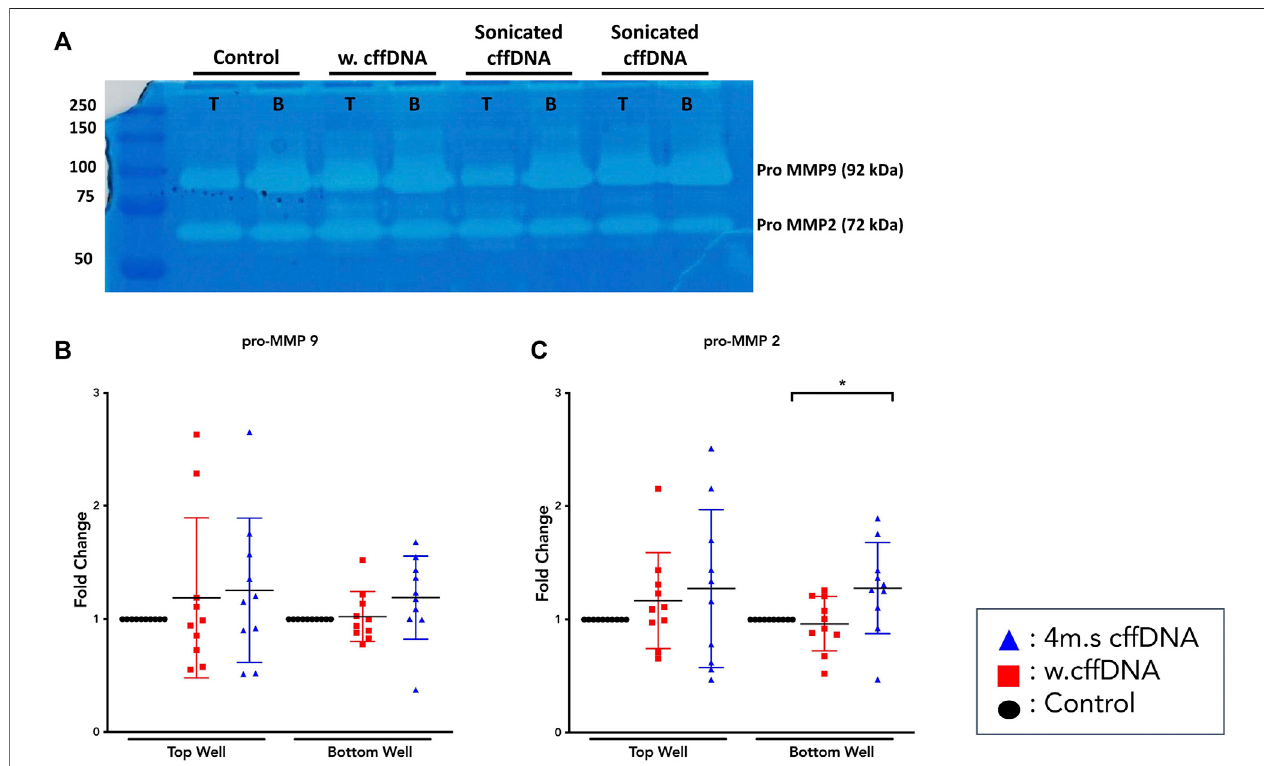
FIGURE 4 | Matrix metalloproteinase activity from fetal membrane explants after treatment with w.cffDNA or 4 m.s. cffDNA. The fold change activity, compared to no treatment control, ofMMPs from the apical (top) well or basal (bottom) well ofthe transwellfetal membrane explant after treatment with (red) w.cffDNA or (blue) 4 m.s cffDNA at 100 ng/ml. (A) Example zymography gel. T = apical, B = basal, (B) Pro-MMP9, and (C) pro-MMP2. n = 10 patients. * p = < 0.05.